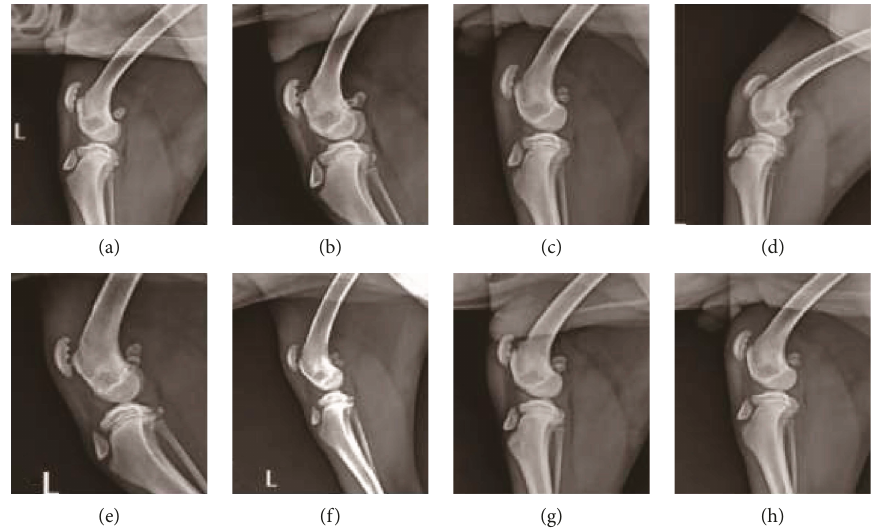
Figure 5: X-ray scan images of canine arthritis after treatment: (a) 3 days after cell therapy, (b) 7 days after cell therapy, (c) 14 days after cell therapy, (d) 28 days after cell therapy, (e) 3 days after treatment in the untreated control group, (f) 7 days after treatment in the untreated control group, (g) 14 days after treatment in the untreated control group, and (h) 28 days after treatment in the untreated control